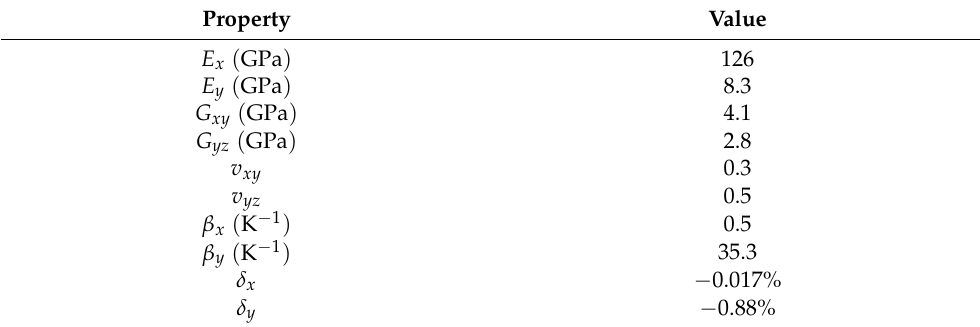
Table 3. Unrelaxed properties of AS4/3501-6 composite [39].